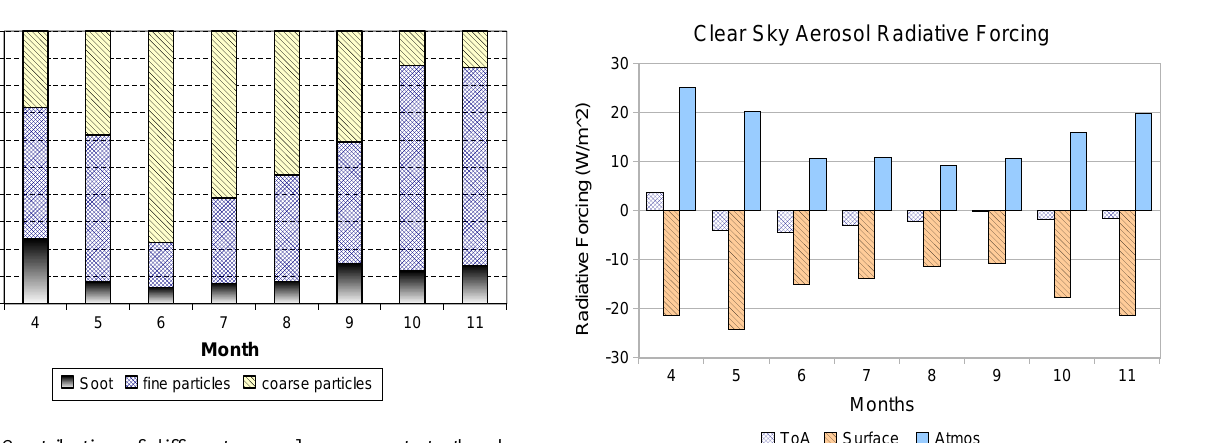
Fig. 10. Contribution of different aerosol components to the ob- served AOD. Fine mode component represent all the fine aerosols except soot.